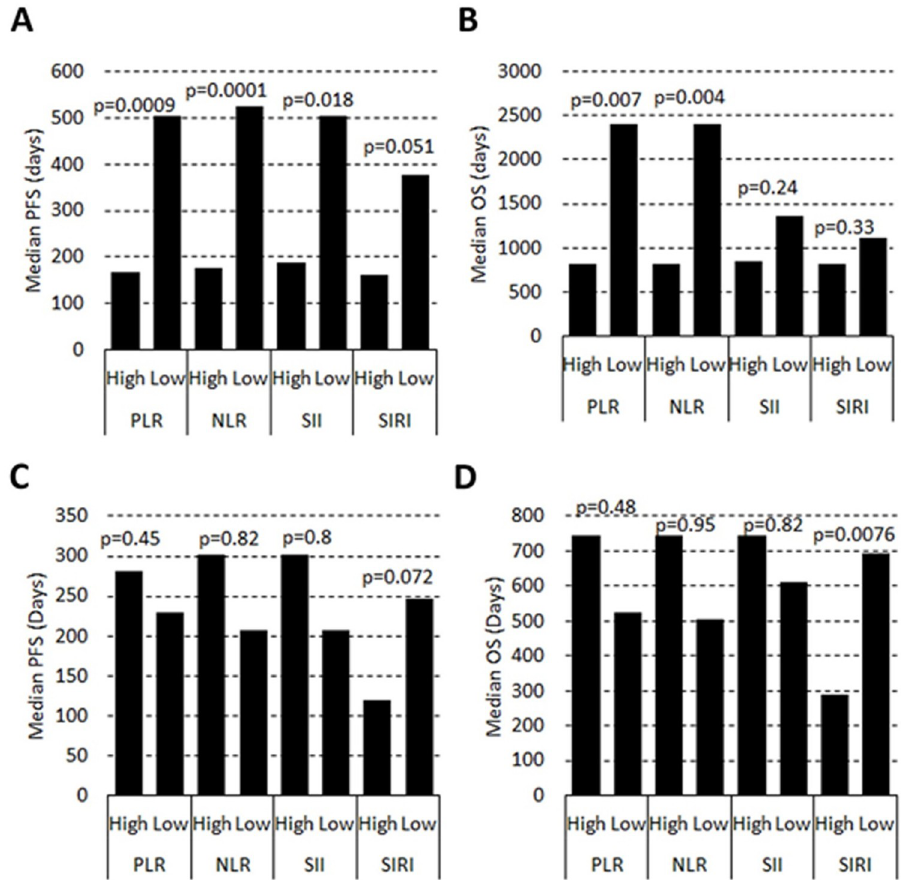
Fig 2. Predicting outcomes in lung cancer using systemic inflammation (SI) markers. NSCLC (A and B) and SCLC (C and D) were separated into high or low SI using the optimized values for each marker based on the 99 th percentile of resected patients with no evidence of disease. Progression-free (A and C) and overall (B and D) survival were determined using Kaplan-Meier curves. Median survival is plotted for each marker and the Log-Rank test p-value for each comparison is shown above the